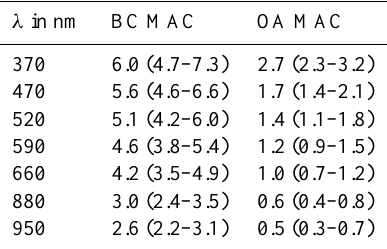
Table 3. Our standard estimates of the MAC for BC (black car- bon) and OA (organic aerosol) in units of m 2 g − 1 . The gram unit in MAC here is for carbon. In this estimate, we only used the data associated with PM 10 /PM 2 . 5 ≤ 1.6 and also absorption coef- ficient ≥ 10 × 10 − 6 m − 1 at 520nm. It is also assumed that there is no OC in BC. The range in brackets denotes the range of obtained MAC at the 95% confidence